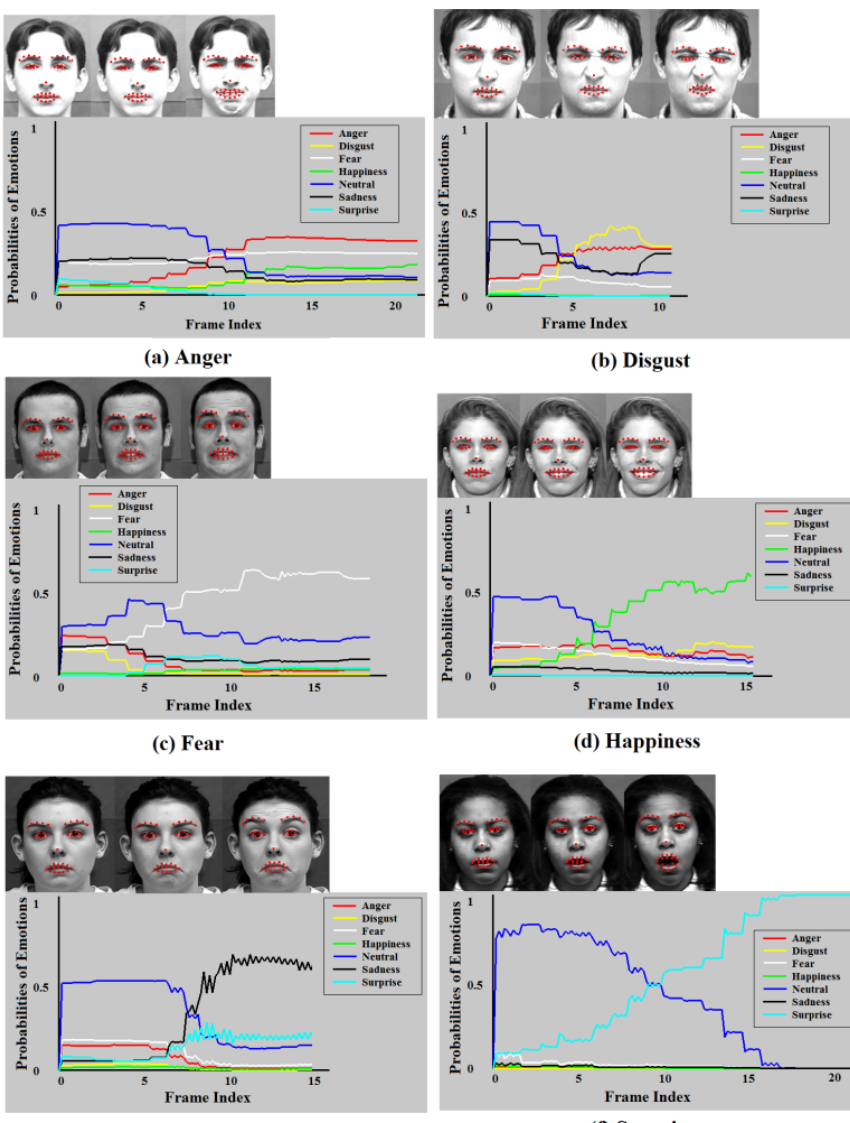
Figure 7. Recognition rates of emotion types as a function of frame index (time) in a video sequence. ( a ) Anger; ( b ) Disgust; ( c ) Fear; ( d ) Happiness; ( e ) Sadness; ( f ) Surprise.